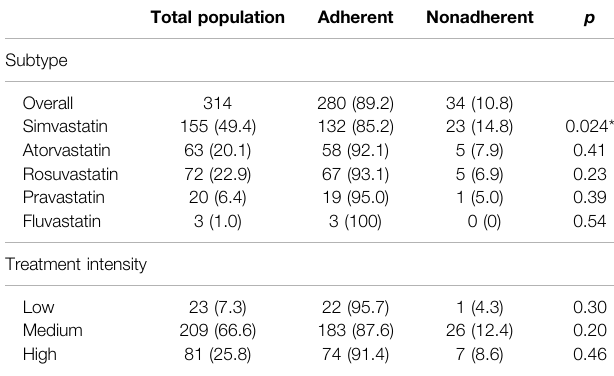
TABLE 2 | Statin subtype prescription and treatment